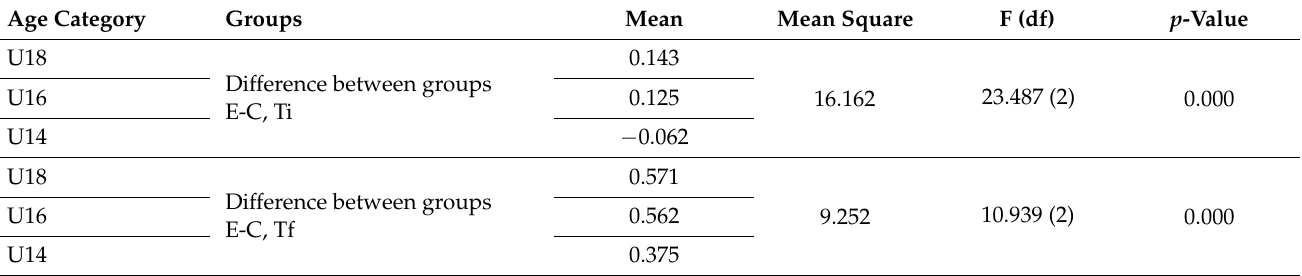
Table 2. ANOVA variance analysis between U14, U16, and U18 for the FRB